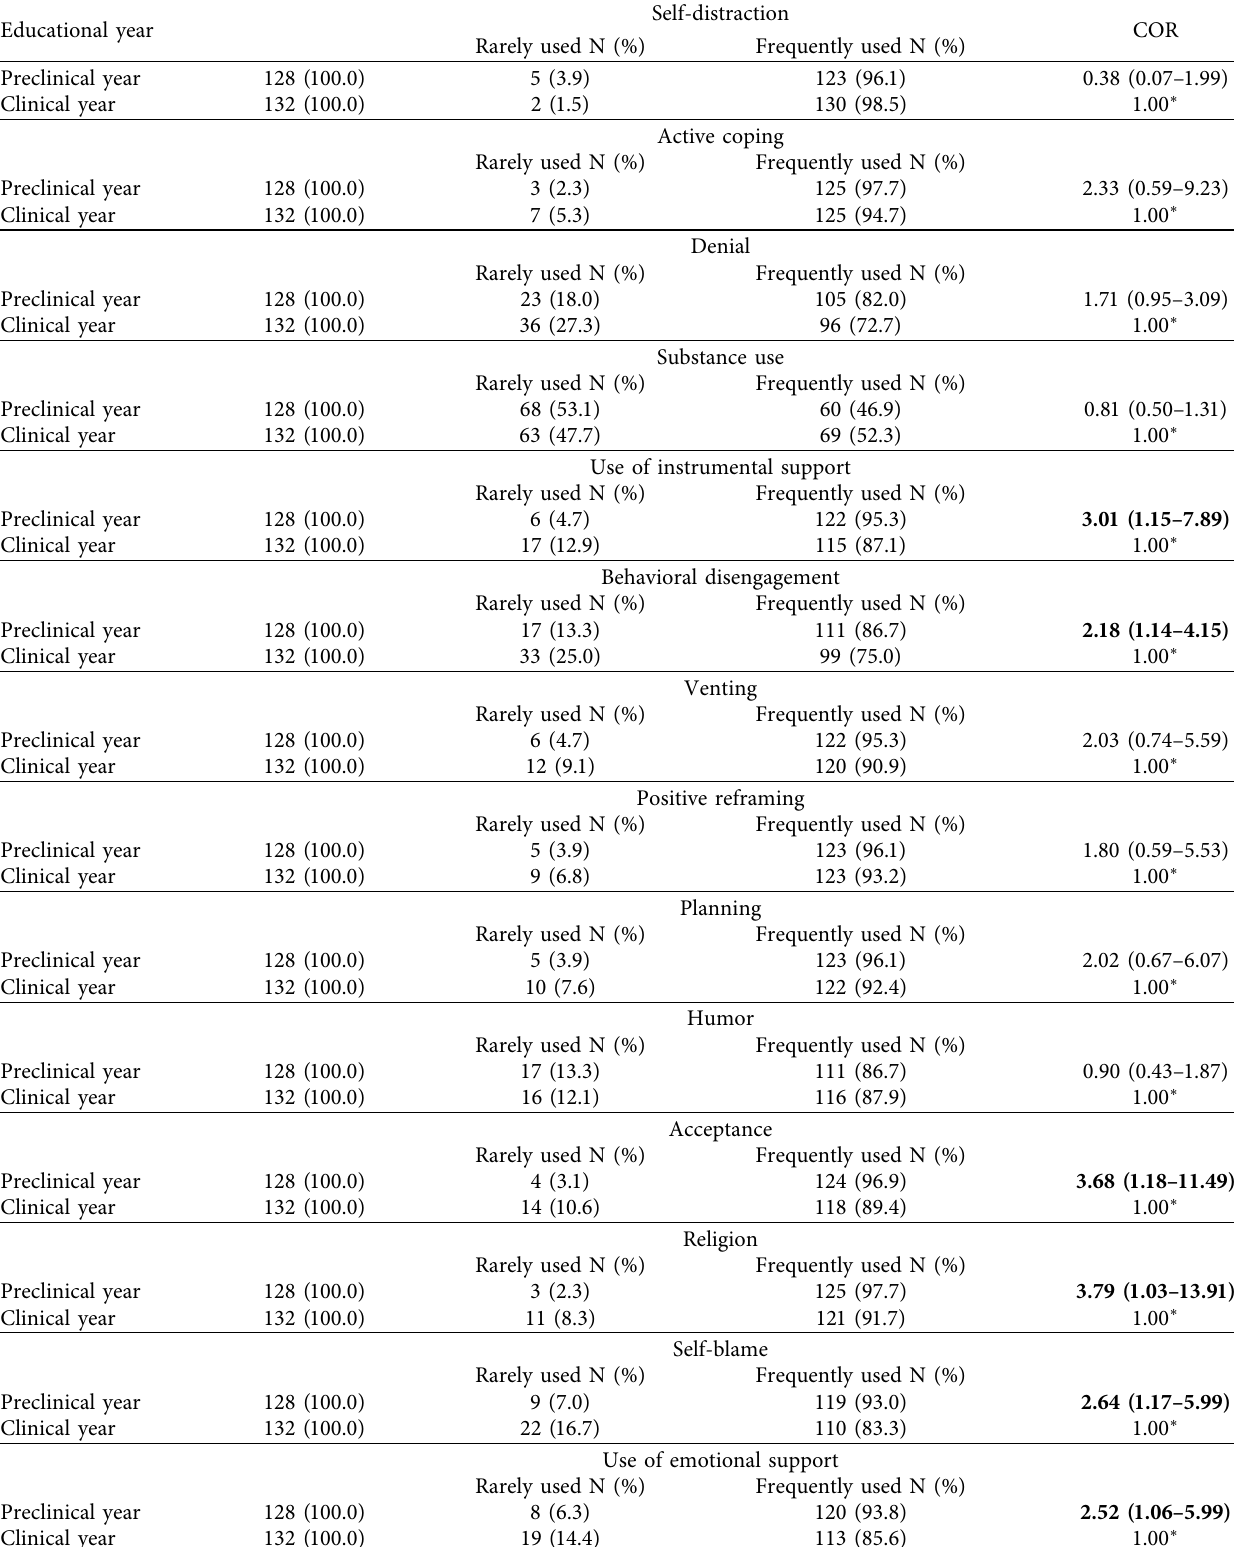
Table 5: Bivariate logistic regression of coping strategies adopted by year of medical education, N � 260, AU, January